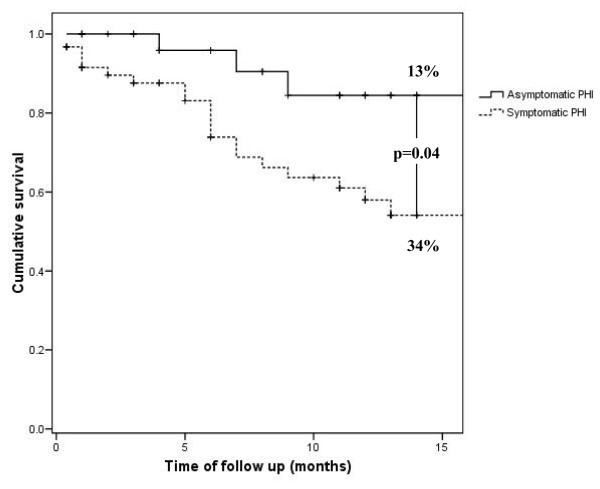
Time to progression of HIV disease among untreated patients from the Grupo Argentino de Seroconversión. Progression-free survival from onset of HIV infection among untreated patients with or without symptomatic primary HIV infection.